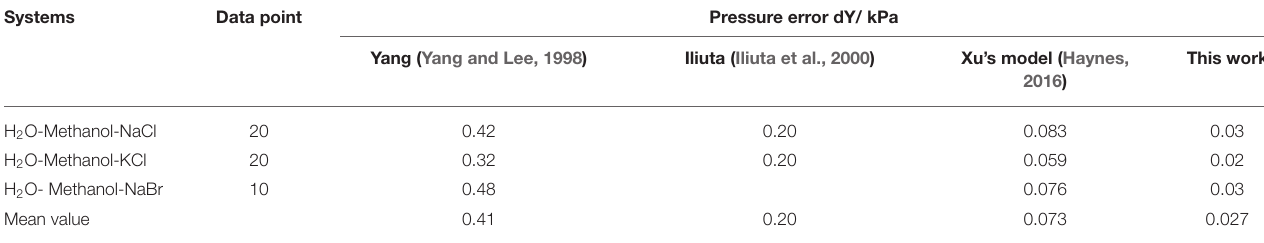
TABLE 6 | Comparison of VLE for H 2 O-methanol-salt systems at 298.15K. Systems